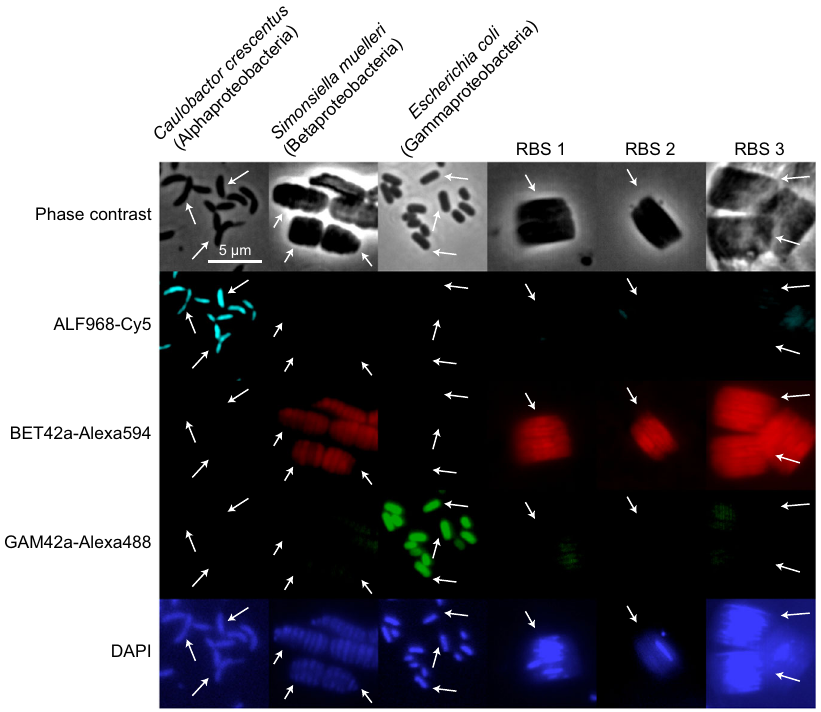
Fig. 3 | Fluorescence in situ hybridization indicates that RBS-As are af fi liated with class Betaproteobacteria. Probes for phylum Proteobacteria classes Alpha- proteobacteria(ALF968),Betaproteobacteria(BET42a),andGammaproteobacteria (GAM42a) were assessed for their ability to hybridize to RBSs. Top row: phase- contrast images; middle three rows from top to bottom: fl uorescence images for